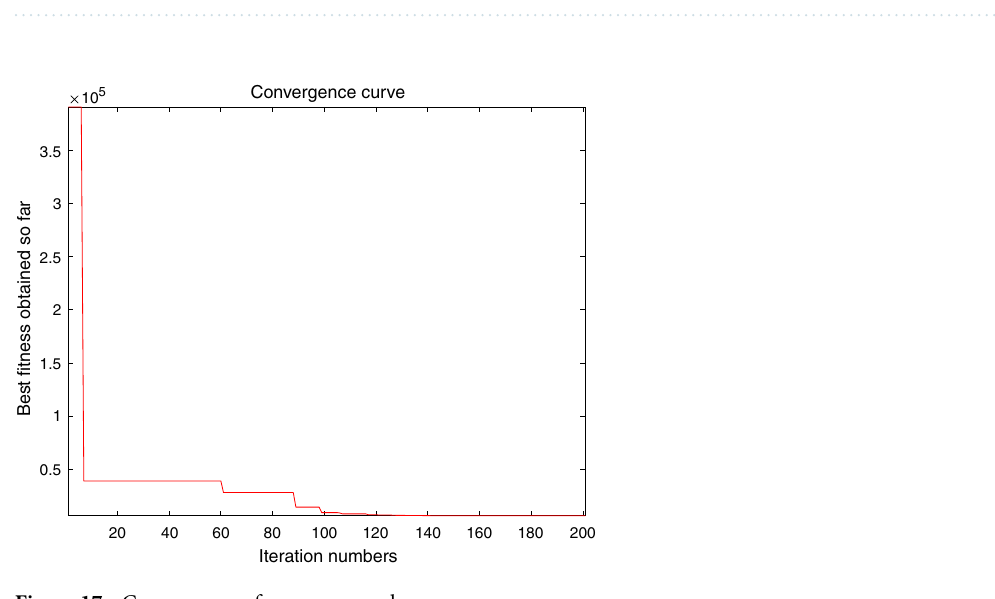
Figure 17. Convergence of pressure